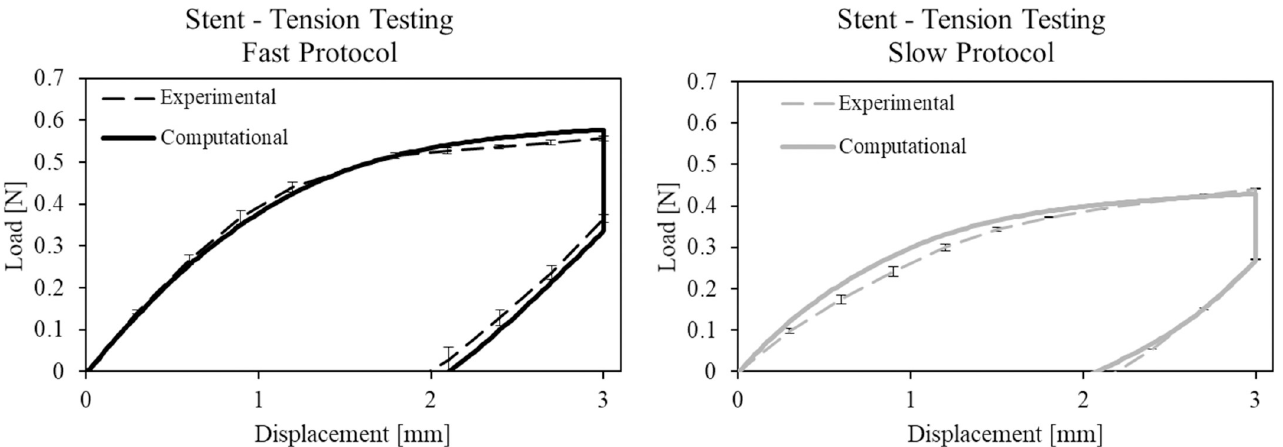
Fig 8. Comparison between experimental and computational force-displacement curves in tension testing of stents. Error bars indicate the maximum and minimum experimental value with respect to the mean value at the corresponding displacement.